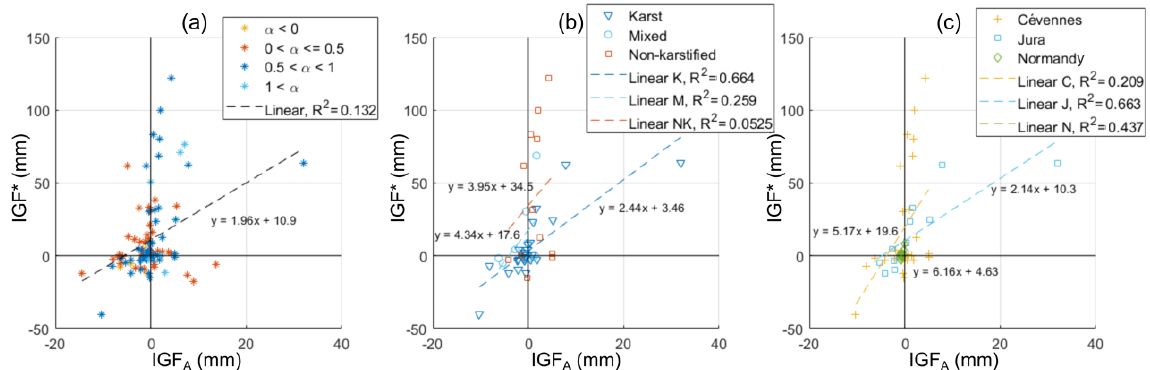
Figure 10. Relationships between multi-annual water-balance-derived IGF A and storm-event-derived IGF ∗ (including potential aquifer stor- age variation) depths. IGF A depth is normalized by event duration for consistent comparisons. First, all 108 elementary catchments were plotted (a) ; then catchments were filtered to retain only α values between 0.5 and 1; these were plotted and grouped by geology type (b) and study area (c)